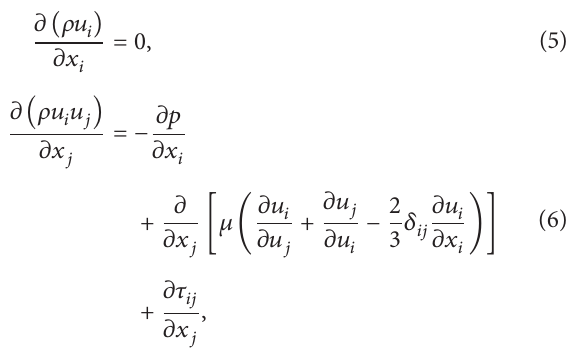
paper. Equation (5) is the continuity equation and (6) is the Reynolds-averaged Navier-Stokes equation.